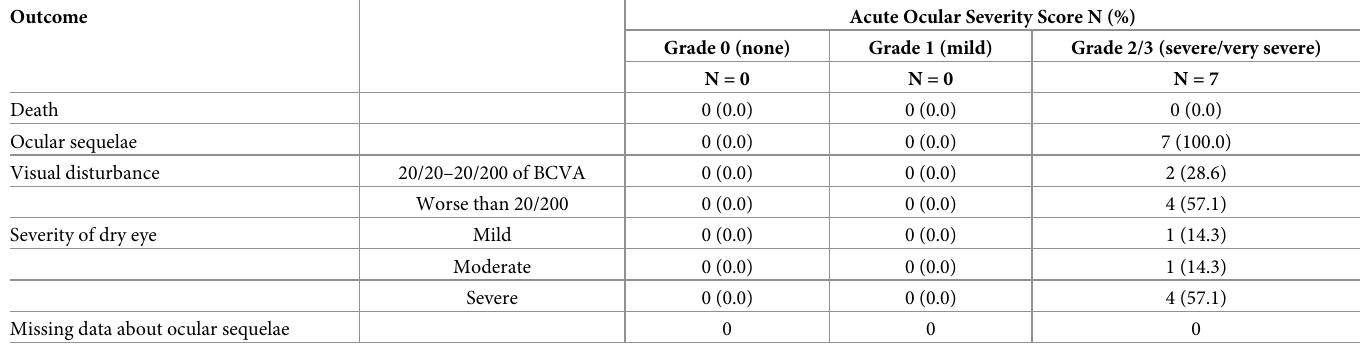
Table 4. Outcomes and ocular sequelae of the patients in whom the time from disease onset to the initial ophthalmological examination was within 30 days but the period of elapsed time from initial presentation to worst-condition follow-up visit was more than 30 days. Outcome